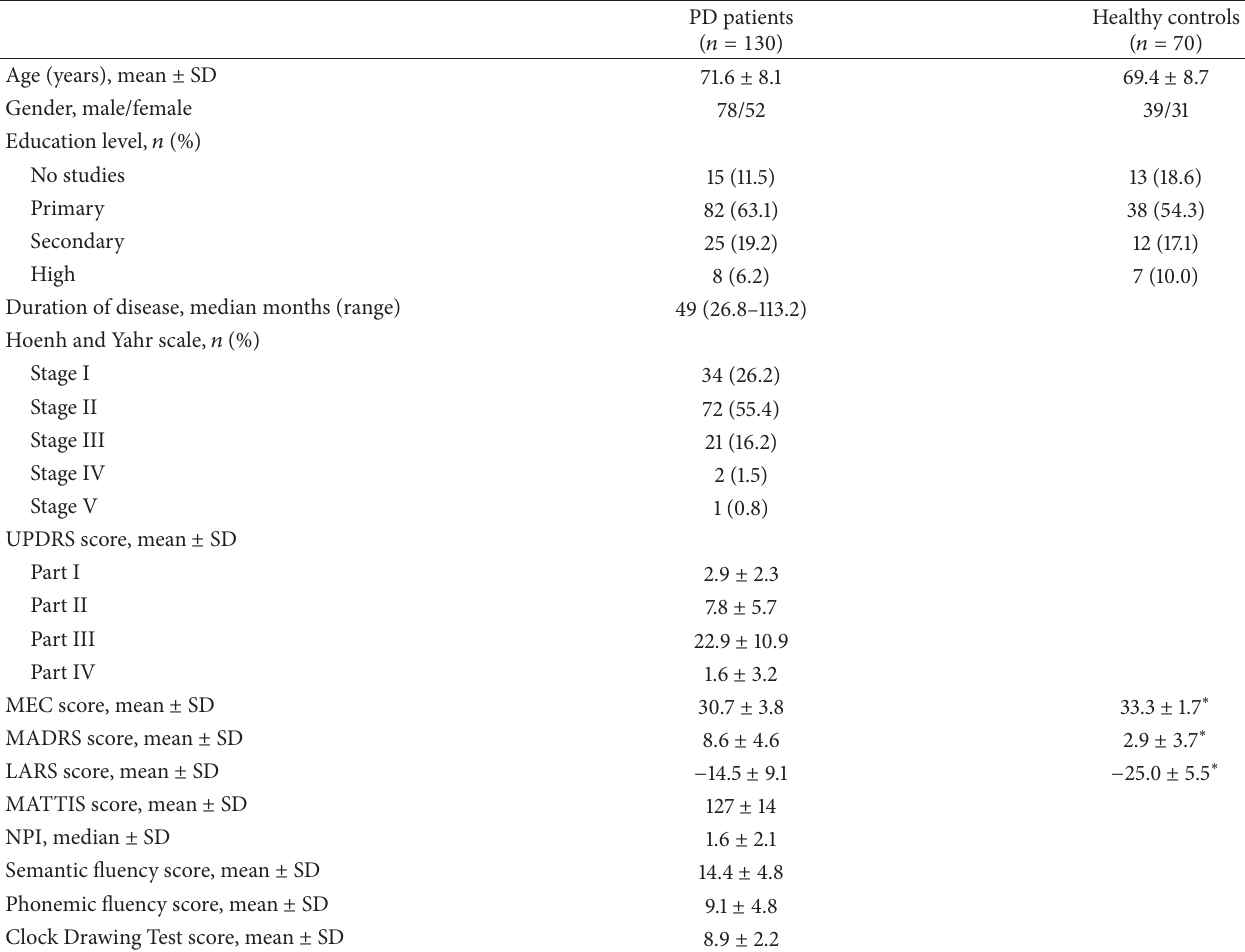
Table 1: Demographic and clinical characteristics of PD patients and healthy